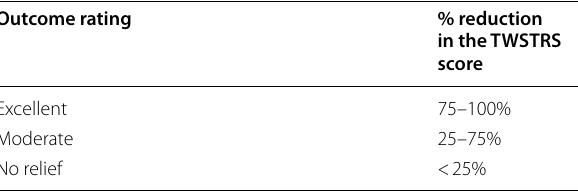
Table 1 Criteria for evaluating the clinical results according to